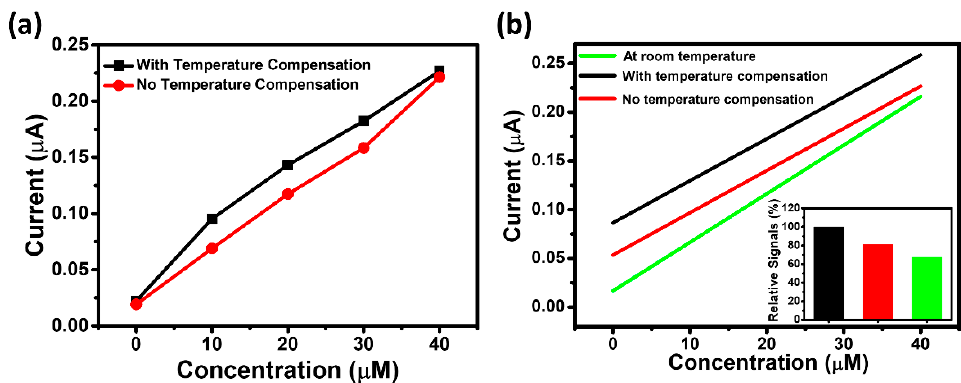
Figure 6. ( a ) Comparative results of uric acid test levels in cold environments with and without insulation from the PSSS. ( b ) Comparative fitting results of uric acid test levels in cold environments with and without the PSSS insulated, as well as at in room temperature (The inset shows the relative average signals for three conditions).